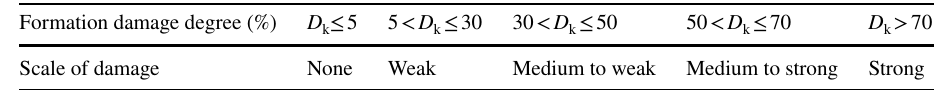
Formation damage degree